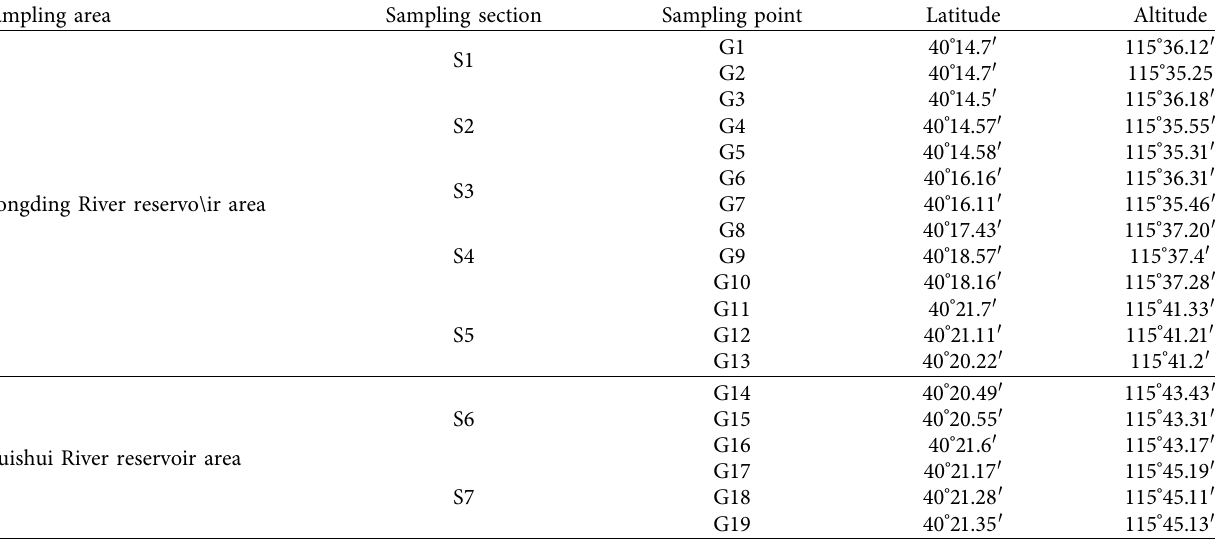
Table 1: General information of sampling points in the Guanting